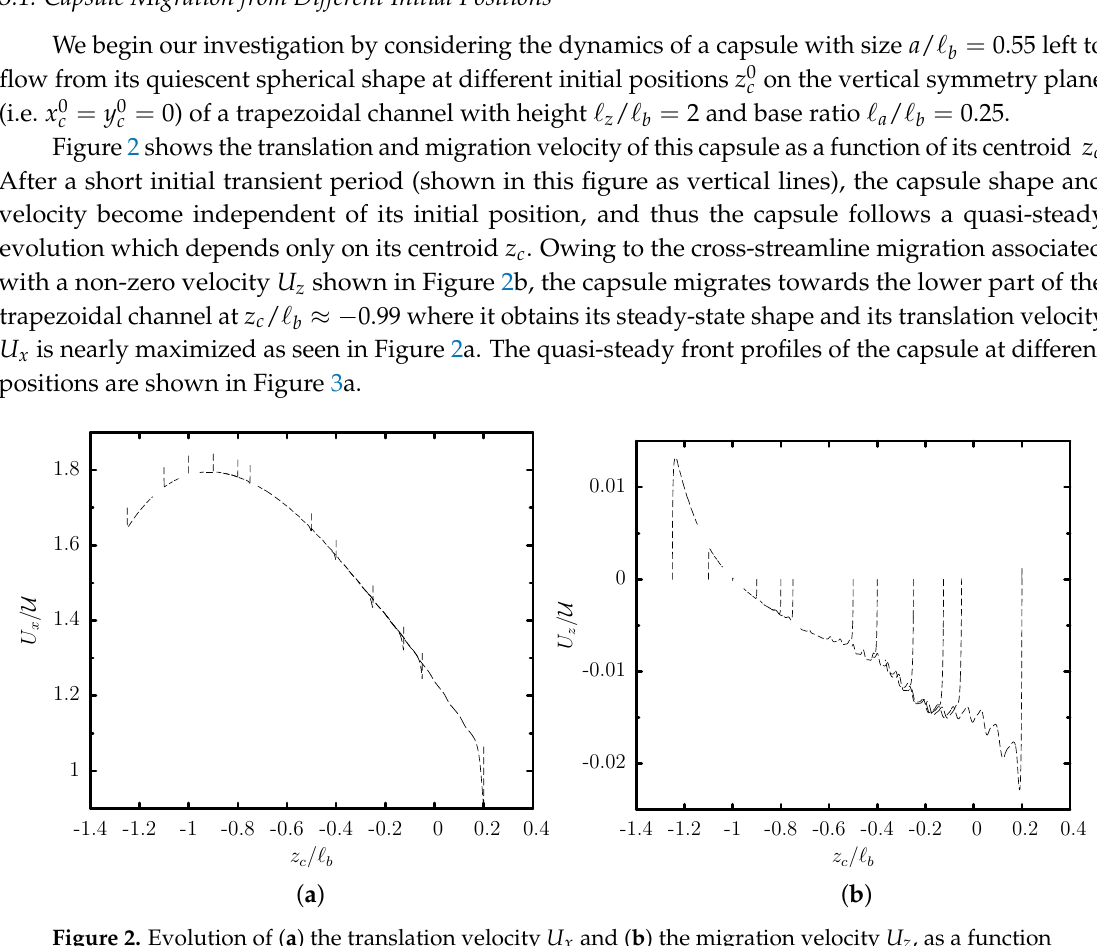
Figure 2. Evolution of ( a ) the translation velocity U x and ( b ) the migration velocity U z , as a function of the centroid z c , for a capsule with a / (cid:96) b = 0.55, Ca = 0.1 and different initial positions z 0 c / (cid:96) b in the range [ 1.25,0.2 ] , flowing in a trapezoidal channel with height (cid:96) z / (cid:96) b = 2 and base ratio (cid:96) a / (cid:96) b = −